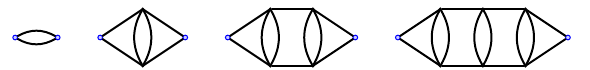
Figure 7 . The caps T 0 , T 1 , T 2 , and T 3 . The blue vertices represent (cid:21) 1